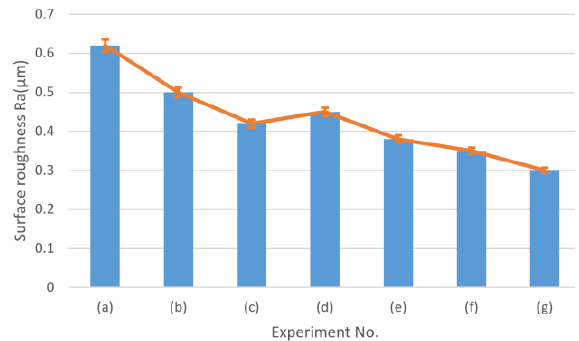
Figure 15. Surface roughness results corresponding to the SEM figures.